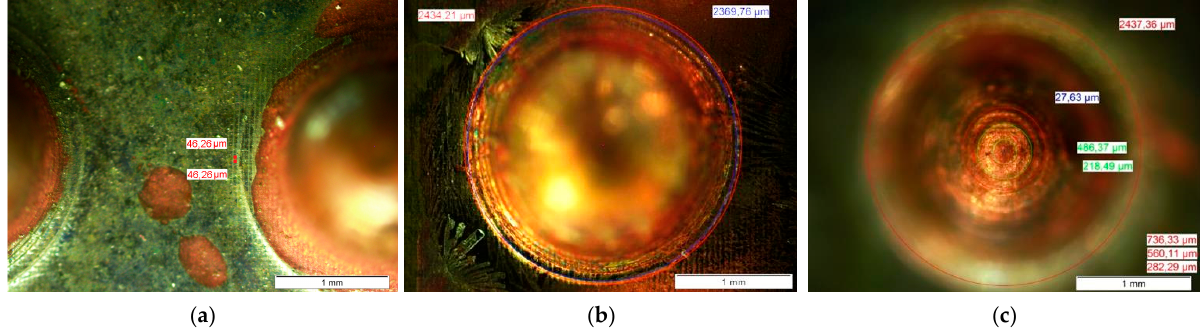
Figure 13. Microscope view (20×) ( a ) Shell Surface. ( b ) Cavity surface. ( c ) Cavity bottom.